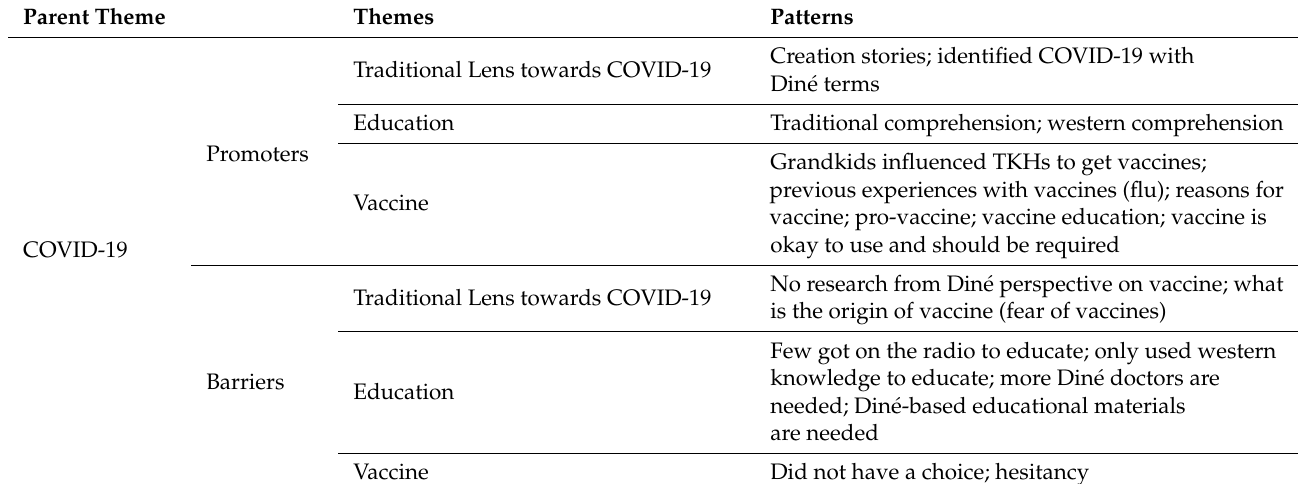
Table 1. Themes and Patterns for the COVID-19 Parent Theme (n = 12) Category.